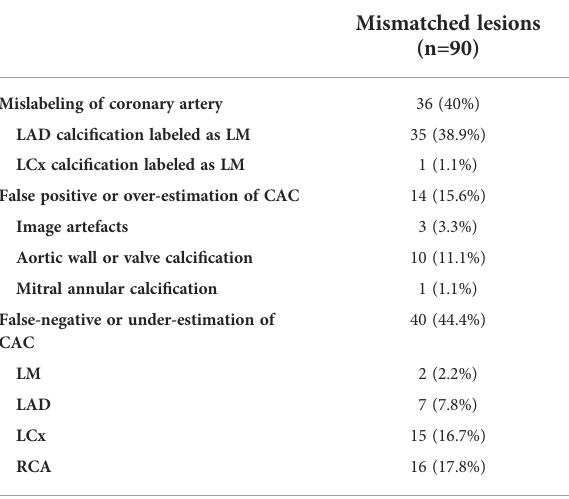
TABLE 4 Per-lesion analysis for the mismatched CACs in the cases outside of 95% limits of agreement on Bland – Altman analysis. Mismatched